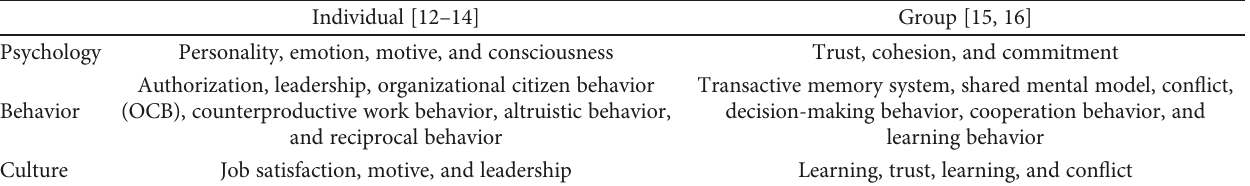
Table 1: Factors in fl uencing individual and group behaviors in mega infrastructure